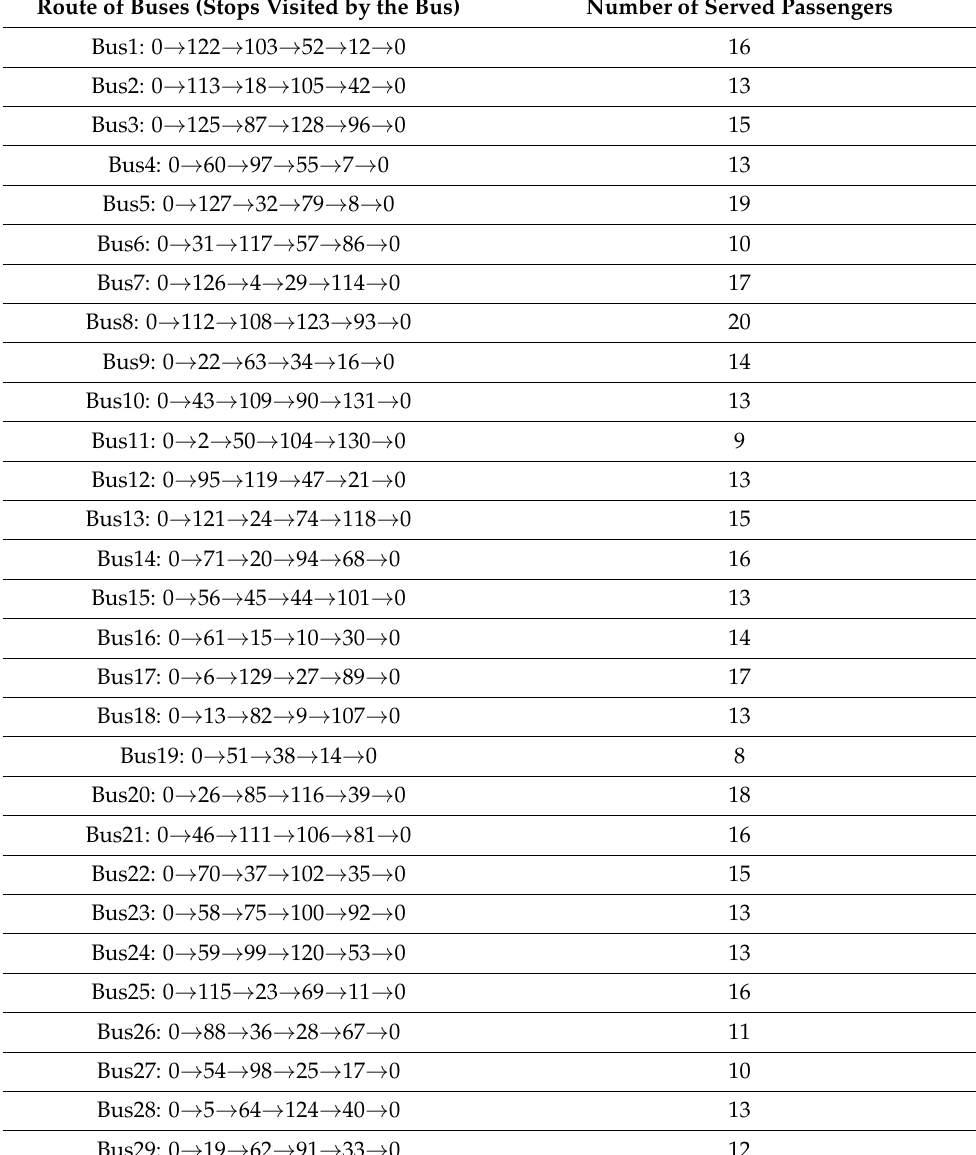
Table 9. Result of the solution route on the Shenzhen airport transport (Total cost: CNY 78,301). Route of Buses (Stops Visited by the